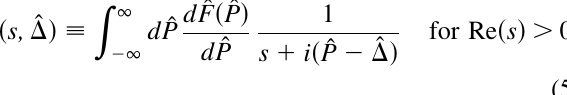
to D approaches an identity map when j s j ! 1 2 2